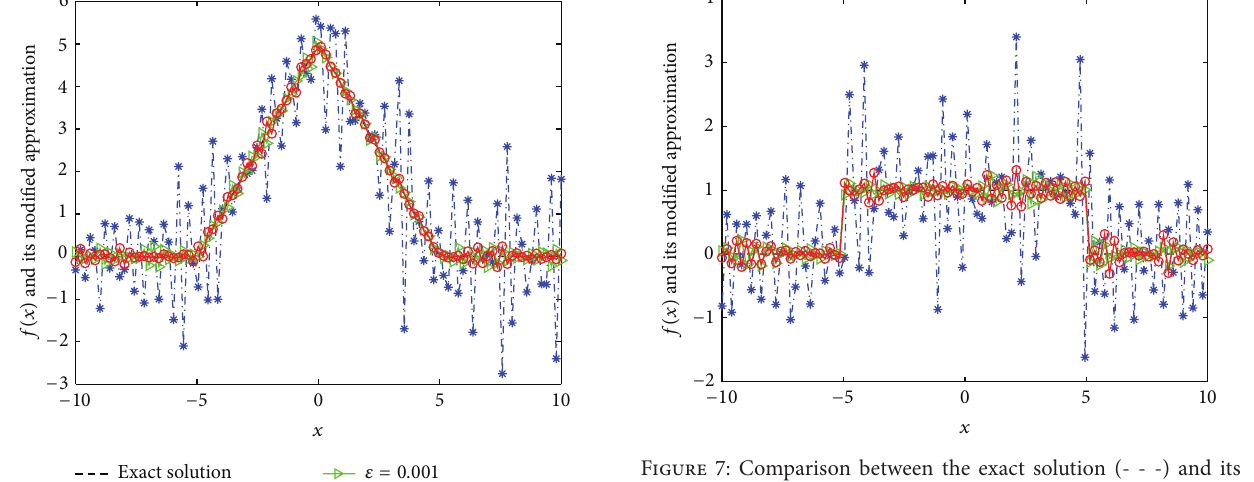
Figure 7: Comparison between the exact solution (- - -) and its computed approximations with 𝑘 = 1 and various noise levels of 𝜀 = 0.01 (−∗−) , 𝜀 = 0.001 (− ⊳ −) , 𝜀 = 0.0001 (− o −) for Example 7.